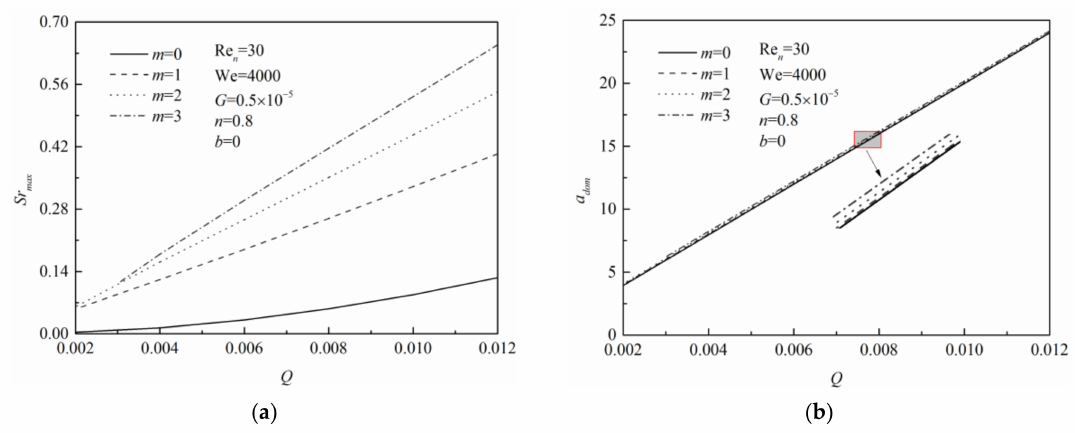
Figure 7. E ff ect of the gas–liquid density ratio Q on the maximum growth rate ( a ) and the dominant wavenumber ( b